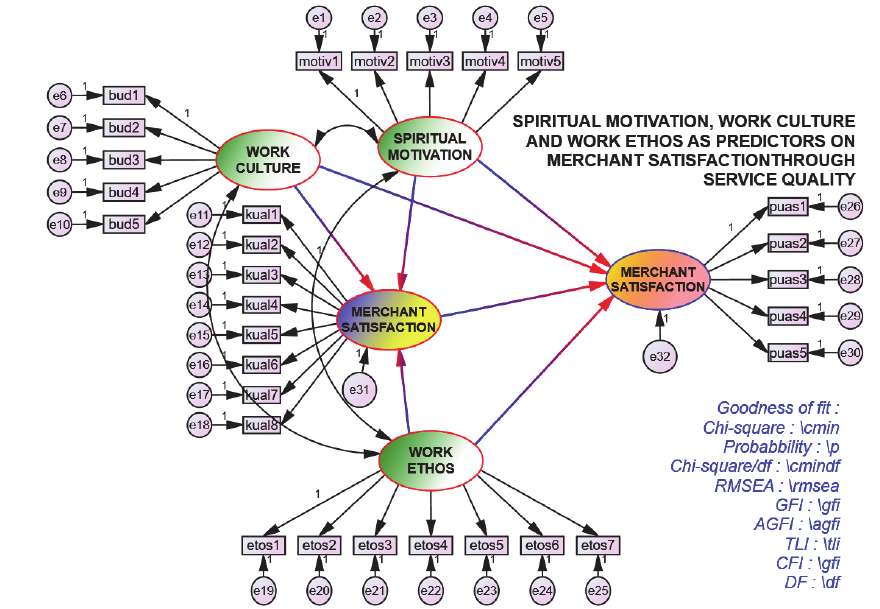
Fig. 1. Spiritual Motivation, Work Culture, and Work Ethos as Predictors On Merchant Satisfaction Through Service Quality of Street Vendors in Badung Market, Bali,